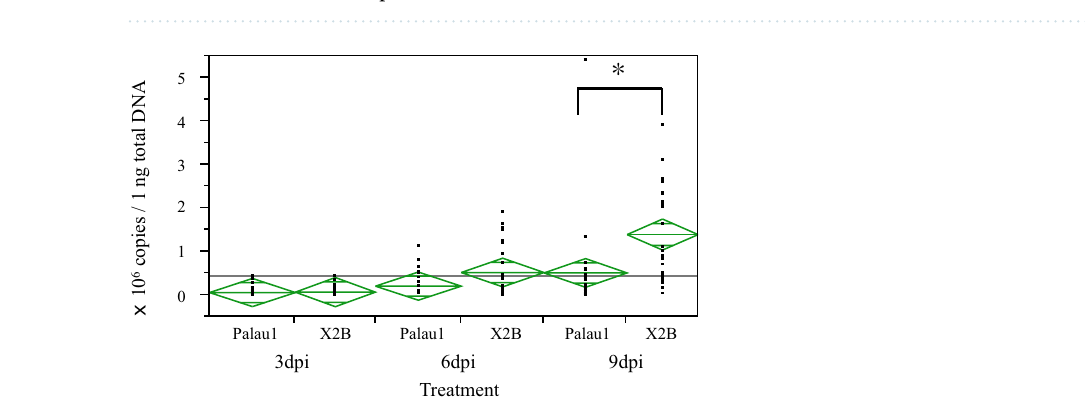
Figure 2. Expression of viral gene and virus particles in Japanese larvae inoculated with Palauan isolate. (A ) Detection of OrNV RNA expression from midgut tissue of Japanese O. rhinoceros larvae inoculated with virus solution. L: 100 bp DNA Ladder (TaKaRa, Japan), N: Negative control (water) amplified by primers of OrNV15ab 1–4: individuals injected with virus solution, P: Positive control for PCR (DNA extracted from O. rhinoceros- infected adult). ( B ) Electron micrographs of tissues from Japanese O. rhinoceros larvae injected with virus solution, and ( C ) mock treatment (injected with PBS). Scale bars for micrographs shown with images. White arrows indicate virus particles.